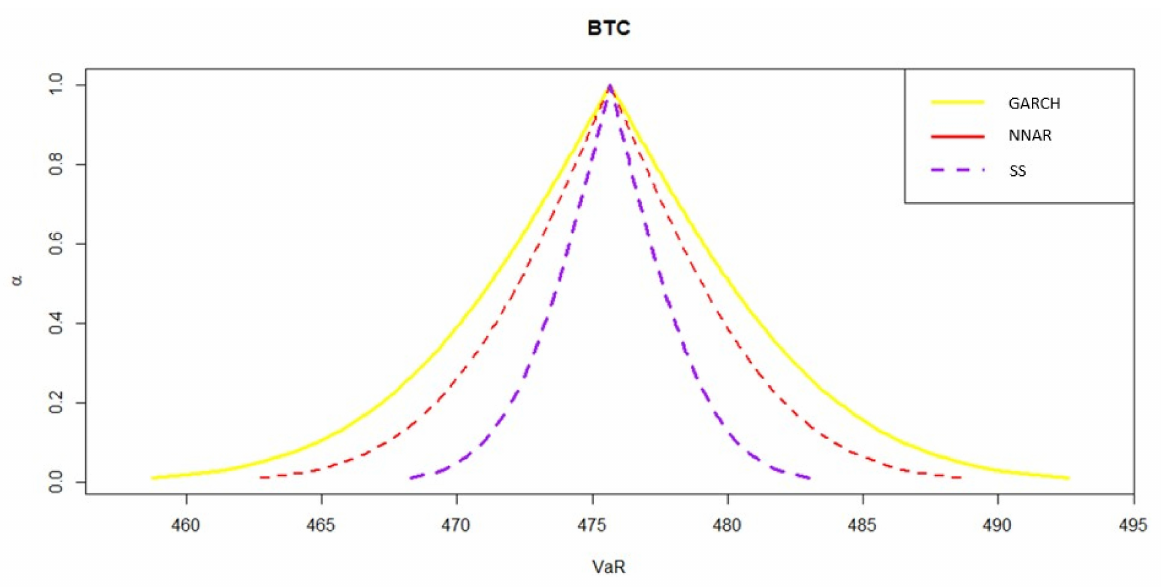
Figure 9. VaR confidence interval for Bitcoin.